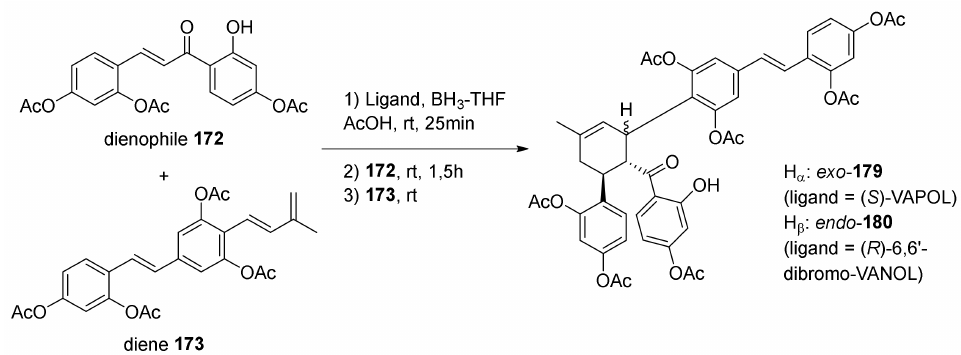
Figure 59. Asymmetric Diels − Alder cycloadditions from dienophile 172 and diene 173 .